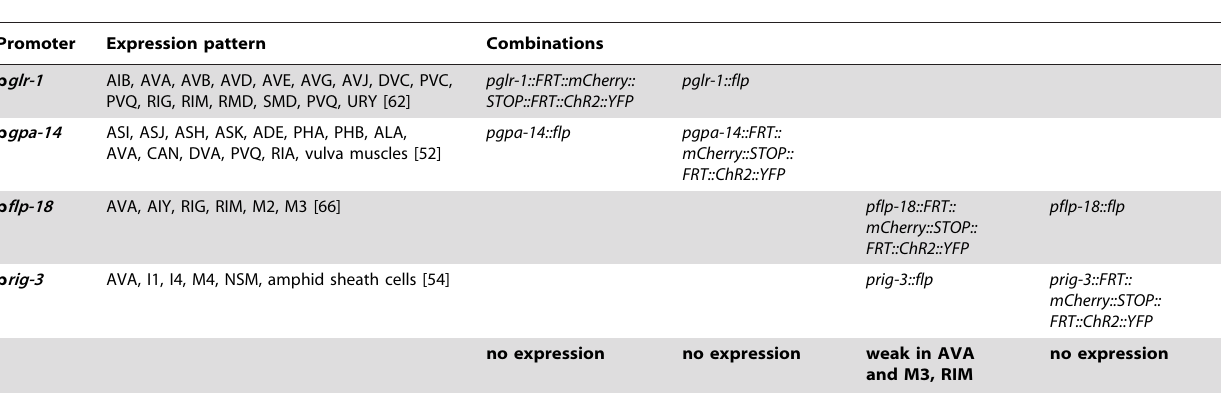
Table 3. Promoter combinations used for AVA specific ChR2 expression (FLP